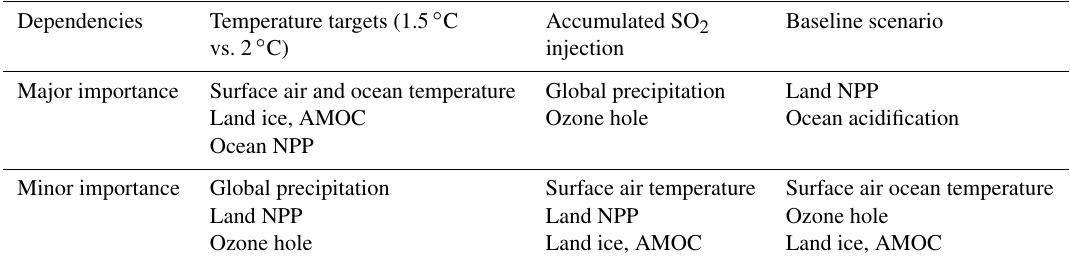
Table 2. Impacts dependent on different measures: achieved temperature targets applying SAG, amount of sulfur burden, and the baseline